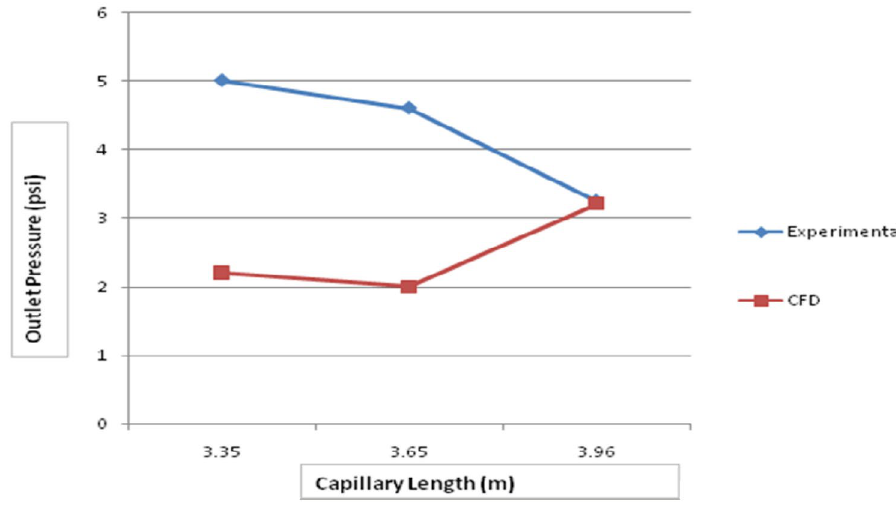
Figure 16. Variation of capillary outlet pressure with various tube lengths for